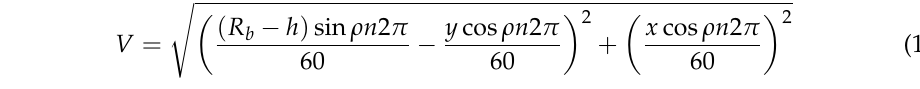
Table 6. The ultimate roughness achieved with BP for different materials. Material